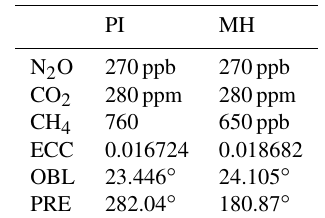
Table 1. Values of orbital parameters and greenhouse gases con- centrations for the PI (left) and MH (right) periods used for the conducted modeling experiments. The orbital parameters are the ec- centricity of the orbit (ECC), the obliquity of the Earth’s axis (OBL) and the precession of the equinoxes (PRE).